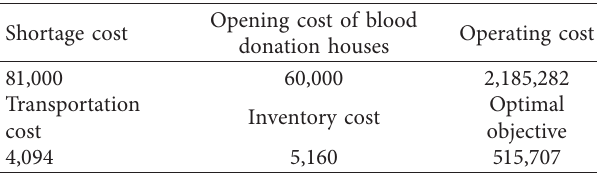
Table 10: Details of the comprehensive costs of the blood supply chain (unit: